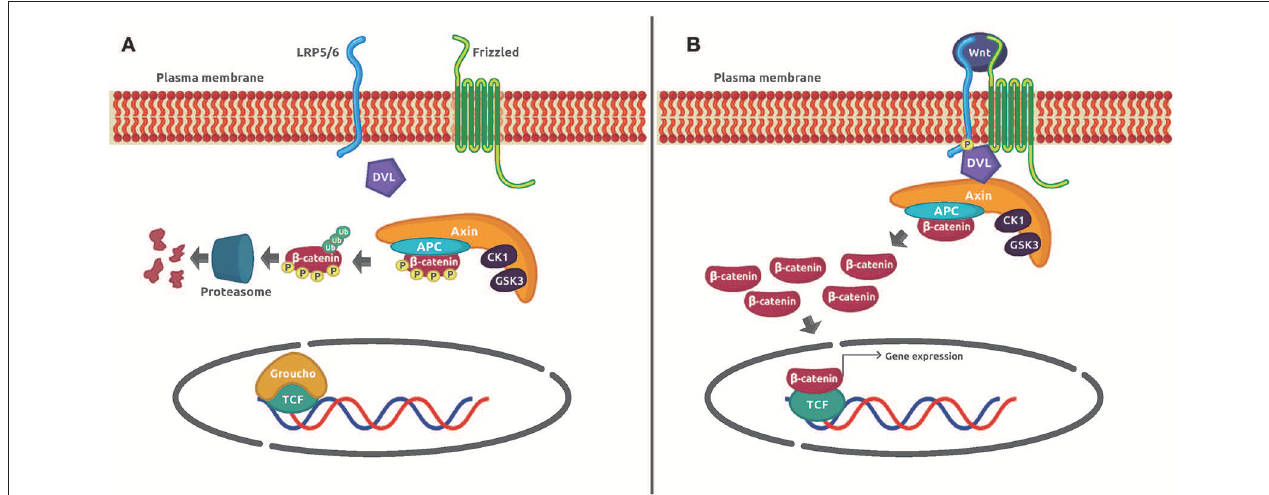
FIGURE 1 | Wnt/ β -catenin signaling mechanism. (A) In unstimulated cells, β -catenin forms a macromolecular complex with Axin, APC, CK1 α , and GSK3 ( destruction complex ). Phosphorylation by CK1 α and GSK3 prepares β -catenin to be ubiquitinated and degraded in the proteasome 26S. (B) The interaction of Wnt glycoprotein ligands with Frizzled receptors and LRP5/6 co-receptors recruits DVL to the plasma membrane. Then, GSK3 phosphorylates LRP5/6 and β -catenin is no longer phosphorylated and ubiquitinated because the destruction complex disassembles. The β -catenin accumulated in the cytoplasm is translocated to the nucleus where it displaces the co-repressor Groucho and interacts with TCF to activate gene expression.